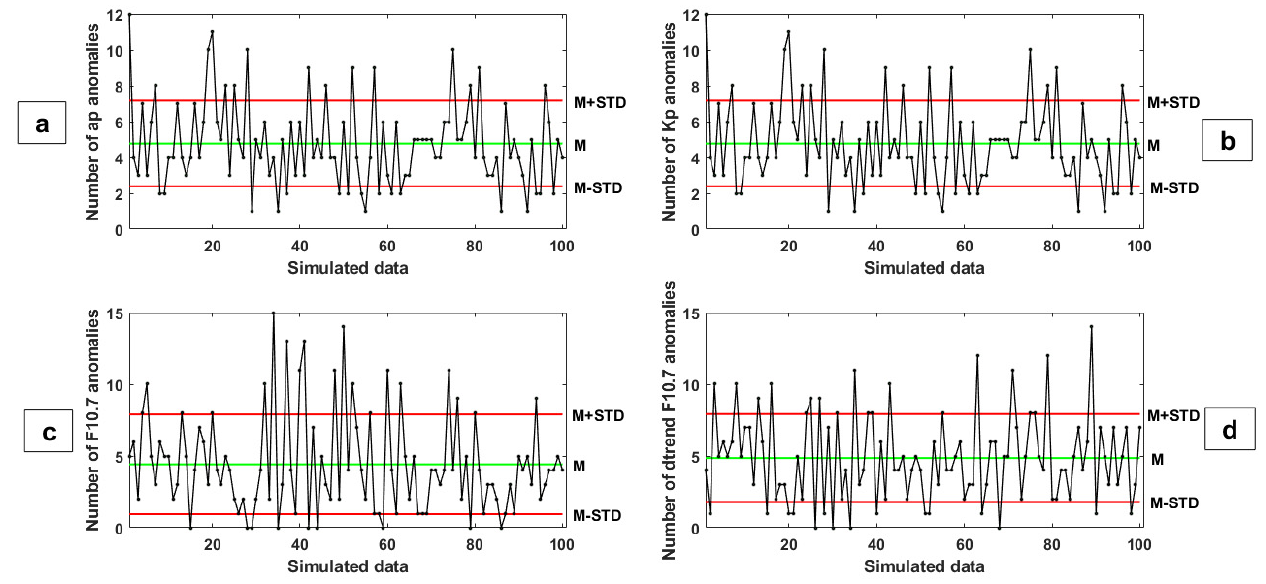
11 of 14 Figure 10. Panels ( a – j ) show results of 10 simulated earthquakes dataset. The y-axis in each panel